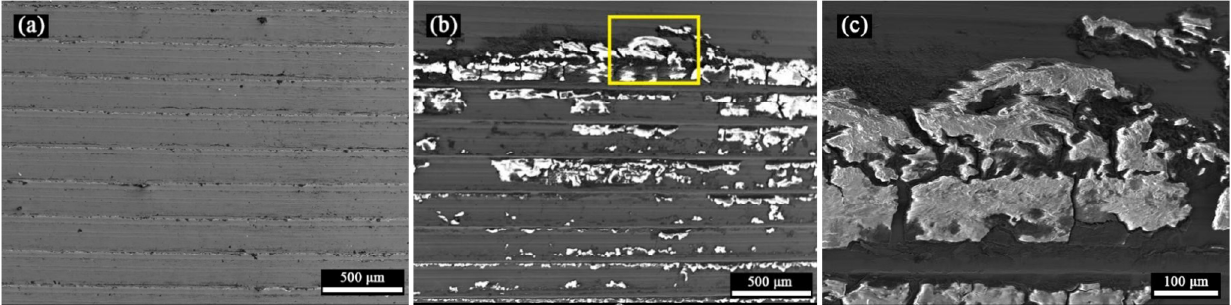
Fig. 9 SEM images at 50× the magnification of the stem trunnion: (a) before and (b) after the test. (c) Magnified view (200×) of the worn area indicated by the yellow box in